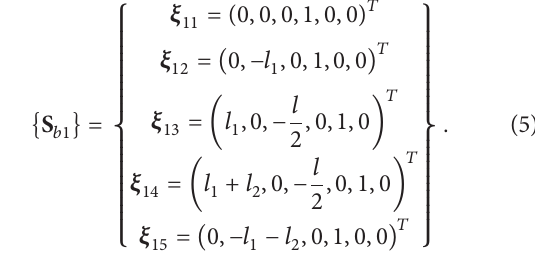
into the single loop mechanism with grasping constraint (Figure 3). The mechanism is composed of a moving platform at the bottom connected to a fixed platform at the top by two